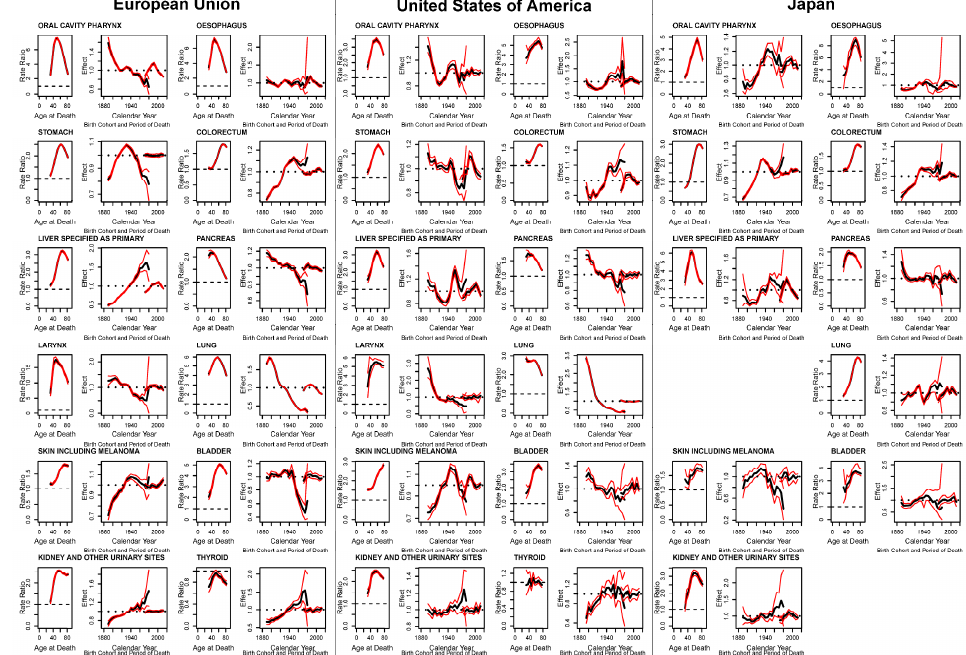
Figure 5. Age-period-cohort analysis of male-to-female sex ratios in major epithelial cancer sites in the EU, USA, and Japan.